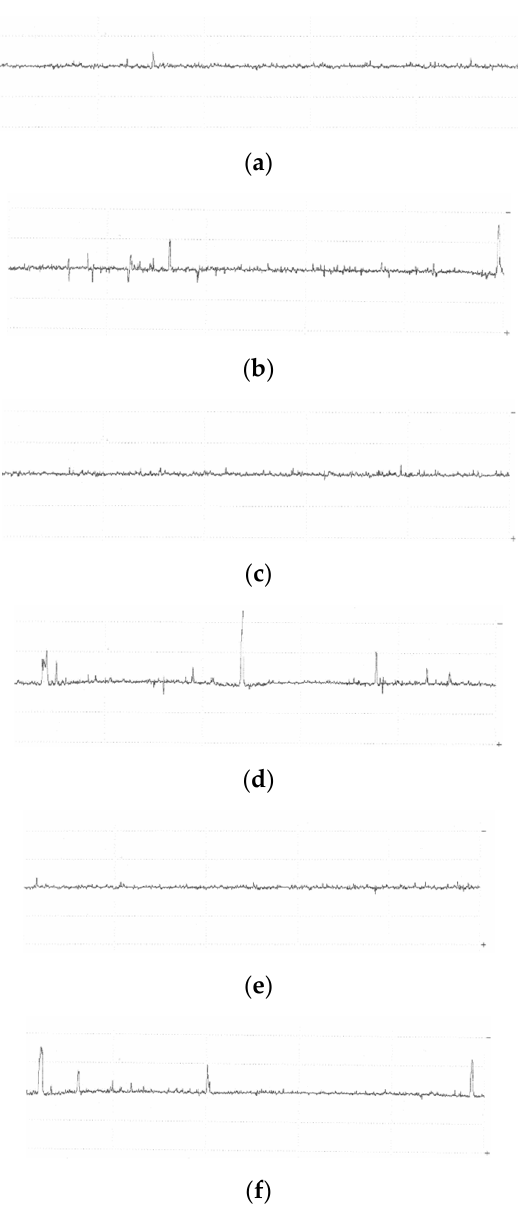
Figure A9. Counterface surface roughness profile for different fibre orientations (AP and P) and neat epoxy under 30 N load at 3.96 m/s of sliding velocity. ( a ) NE- before, Ra = 0.078 µm. ( b ) NE-after, Ra = 0.126 µm. ( c ) AP-before, Ra = 0.078 µm. ( d ) AP-after, Ra = 0.166 µm. ( e ) P-before, Ra = 0.074 µm. ( f ) P-after, Ra = 0.145 µm.